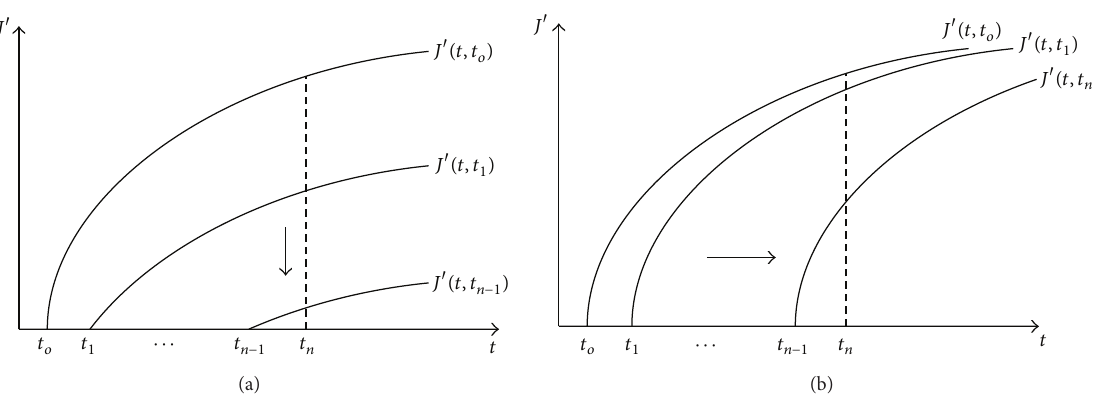
Figure 1: Parallel creep curves: (a) vertical parallel creep curve and (b) horizontal parallel creep